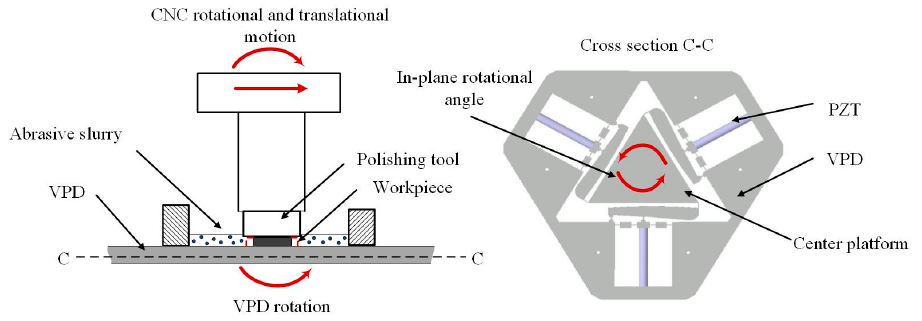
Figure 2. Configuration of the 3D rotary vibration-assisted micropolishing system (RVMS).